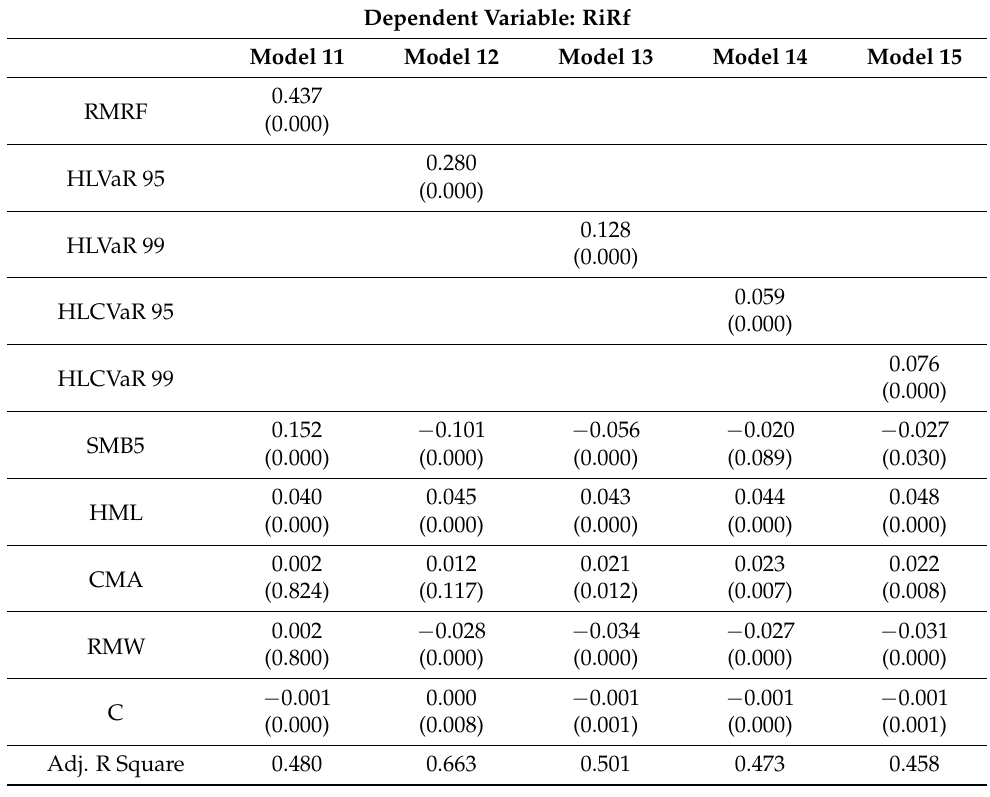
Table 8. Five-factor model using market Beta, VaR, and ES. The table represents five models with the dependent variable of excess returns of manufacturing companies listed on the Pakistan Stock Exchange. Independent variables include all systematic risk factors which the study proposed. Market excess return RmRf is calculated from the subtraction of KSE 100 Index returns from the risk-free rate of returns. HLVaR subtracts average returns of High VaR portfolio returns from Low VaR portfolio returns. VaR is observed at both 95% and 99% level of significance. HLCVaR represents subtraction of high ES return stocks from low ES returns stocks. SMB provides size factor, HML is a value factor, and RMW estimates the investment factor represented by CMA and profitability. All models offer results of the three-factor model with substituting systematic risk factor. Italic probability value is provided below every coefficient value representing the significance of the coefficient effect dependent